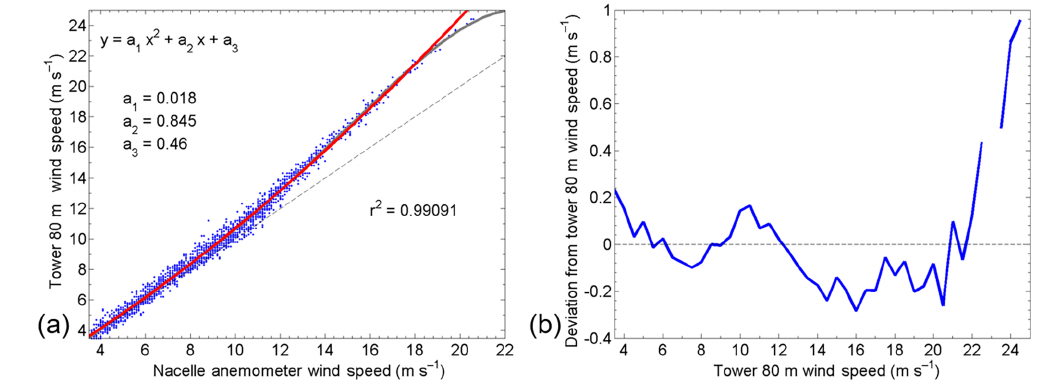
Figure 3. Comparison of upwind wind speeds with nacelle anemometer wind speeds. The red line in panel (a) is the second-order polynomial fit and empirical transfer function between the tower 80m observations and the nacelle-mounted anemometer observations. The gray line in panel (a) is the fifth-order polynomial fit. (b) Average deviation in the second-order polynomial NTF-corrected nacelle-mounted anemometer wind speed from tower 80m wind speed versus tower 80m wind speed is shown.